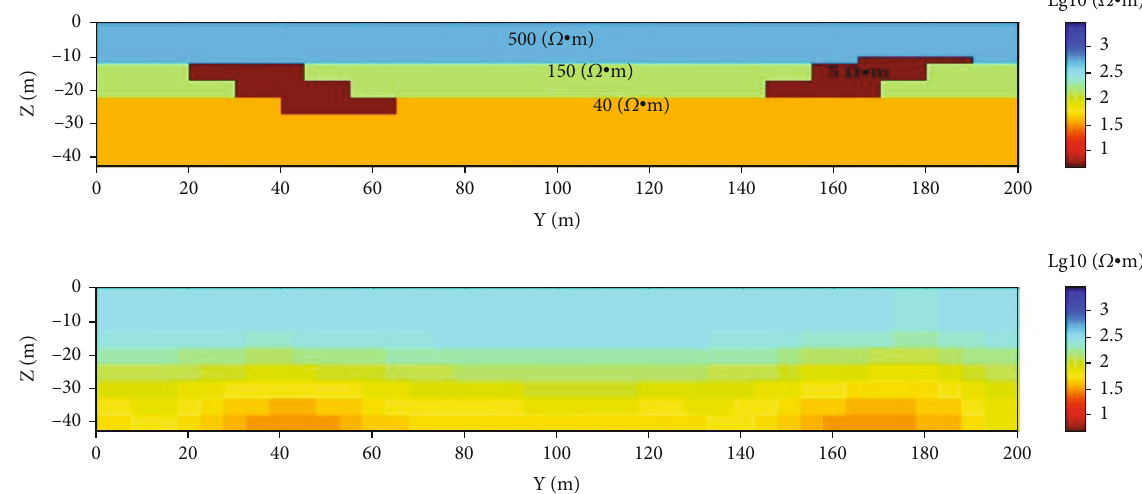
Figure 13: Model of autumn and forward simulation